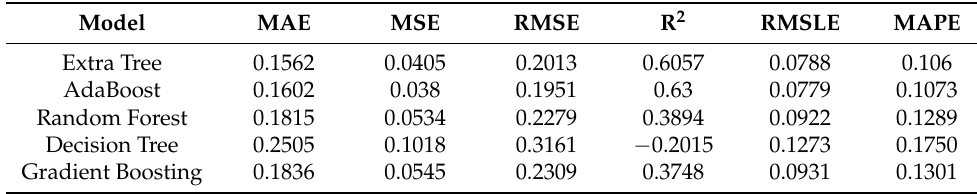
Table 2. Performance comparison of tree-based models.